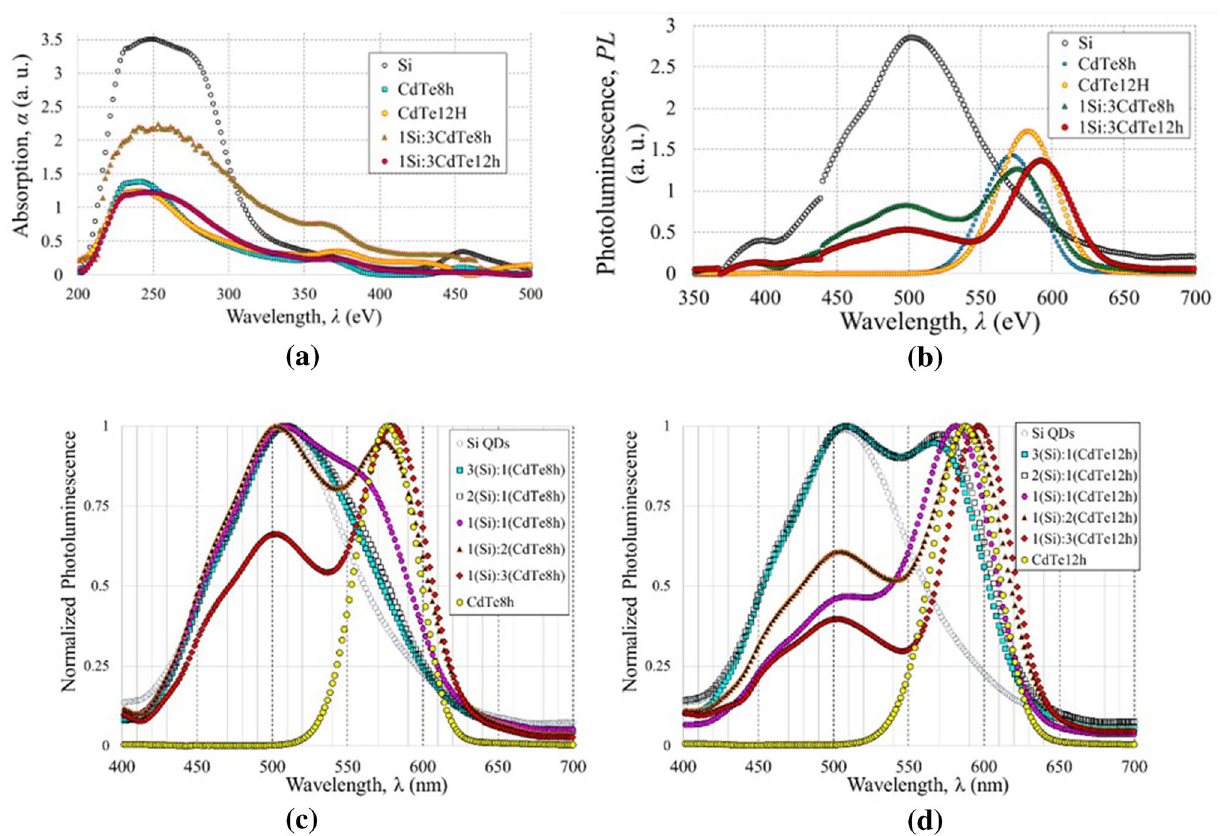
Fig. 3 Absorption and photoluminescent emission spectra of Si and CdTe QDs dispersions